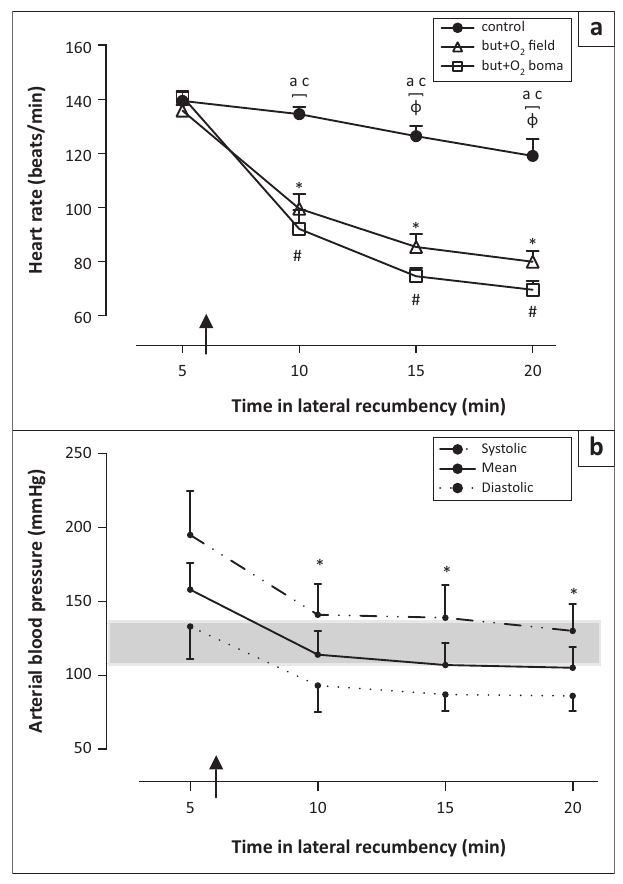
Note: (a) Mean and s.d. of the heart rate (beats/min) of field-immobilised rhinoceroses given intravenous butorphanol + oxygen insufflation (but + O field, n = 14), boma-immobilised 2 rhinoceroses given intravenous butorphanol + oxygen insufflation (but + O boma, n = 8) and 2 boma-immobilised rhinoceroses given intravenous sterile water (control, n = 8). The asterisk ( * ) indicates values in the field trial that differed from pre-intervention values (5 min), whilst # indicates values in the boma treatment trial that differed from pre-intervention values (5 min) and ϕ indicates values in the boma control trial that differed from values at 5 min. The brackets indicate the time points at which the butorphanol + oxygen field trial differed from the control (a) or the butorphanol + oxygen boma trial differed from the control (c); (b) mean and s.d. of arterial blood pressure (mmHg) in field-immobilised rhinoceroses. The black arrow indicates the time at which butorphanol was administered and oxygen insufflation initiated. The asterisk ( * ) indicates values that differed from pre-intervention values (5 min), whilst the shaded area represents the normal range of the indirect mean arterial pressure in standing, unrestrained white rhinoceroses (Citino & Bush 2007). FIGURE 4: (a, b) Heart rate and arterial blood